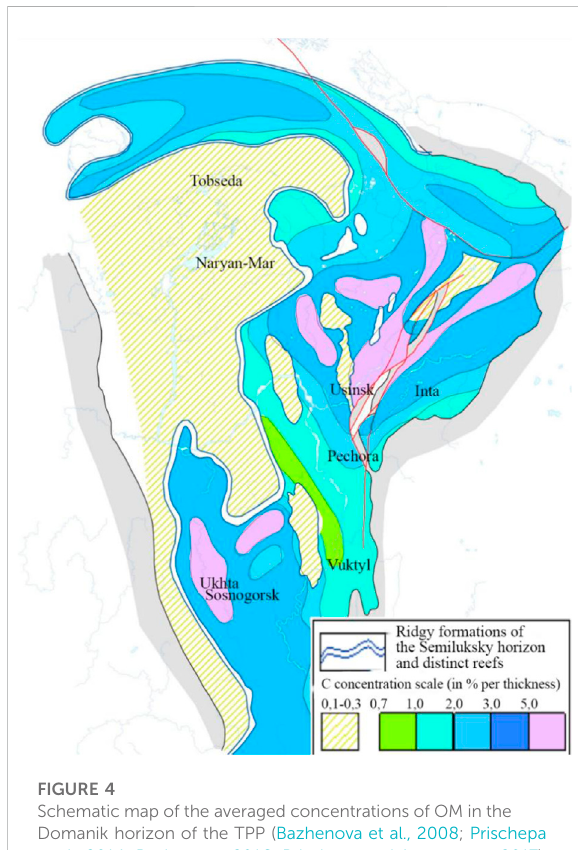
FIGURE 4 Schematic map of the averaged concentrations of OM in the Domanik horizon of the TPP (Bazhenova et al., 2008; Prischepa et al., 2014; Bazhenova, 2016; Prischepa and Averyanova,